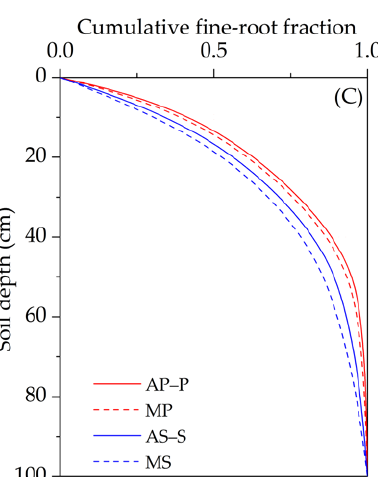
Figure 4. ( A ) Fitting of Equation (1) to a profile of the cumulative fractional fine-root biomass density ( Y ); the dotted lines mark the depth of 50% of the cumulative fine-root biomass density ( d 50 ); ( B ) mean profiles of Y for monocropped apple trees (MA), intercropped apple trees in apple–peanut intercropping systems (AP–A) and intercropped apple trees in apple–soybean intercropping